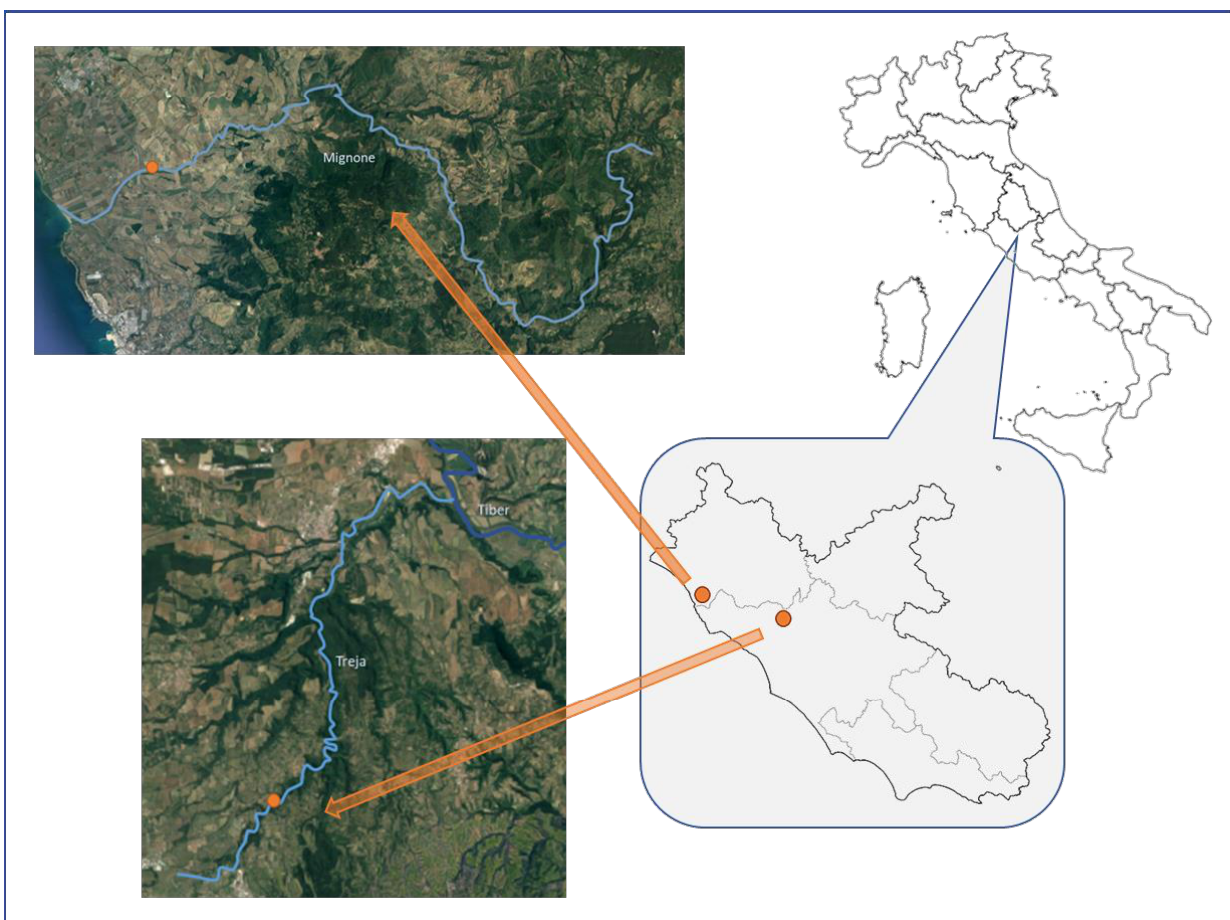
Figure 1. Sampling sites where blackfly larvae (Simuliidae) were collected; the Mignone and Treja rivers are located near Rome, in Lazio, Italy.